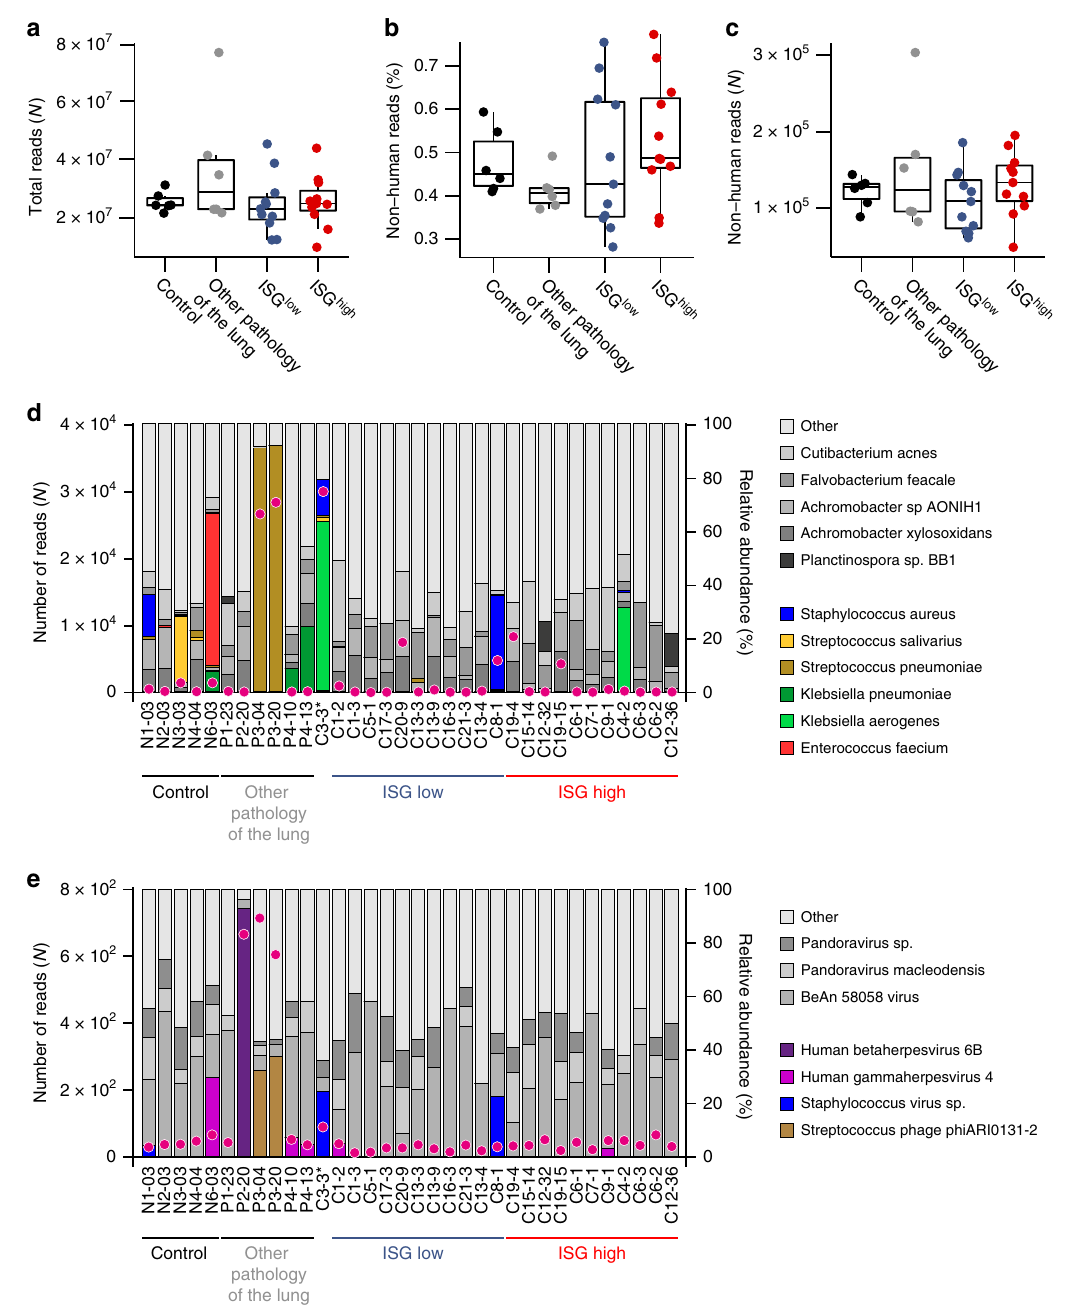
Fig. 2 Co-infections in COVID-19 lungs identi fi ed by WGS metagenomics. No differences in co-infections in ISG high and ISG low COVID-19 lungs identi fi ed by WGS metagenomics. a Total number of reads generated for each sample. b Percentage of reads and c absolute numbers of reads not mapping to the human genome (GRCh37 hg19) ( n = 34 independent samples). Box-plots elements indicate the median (center line), upper and lower quartiles (box limits). Whiskers extend to the most extreme value included in 1.5× interquartile range. d Bacterial and e viral co-infections across lung samples, WGS metagenomic analysis. Purple dots, numbers of reads suf fi cient for identi fi cation of non-human species. Samples are ordered by increasing the SARS-CoV-2 viral load in both the ISG low and the ISG high group. Stacked bars, the relative abundance of the most common species. Gray bars represent frequent species, colored bars show pathogenic species. *One COVID-19 patient (C3) clustered in the normal control group. ISG high samples, red; ISG low samples, blue.